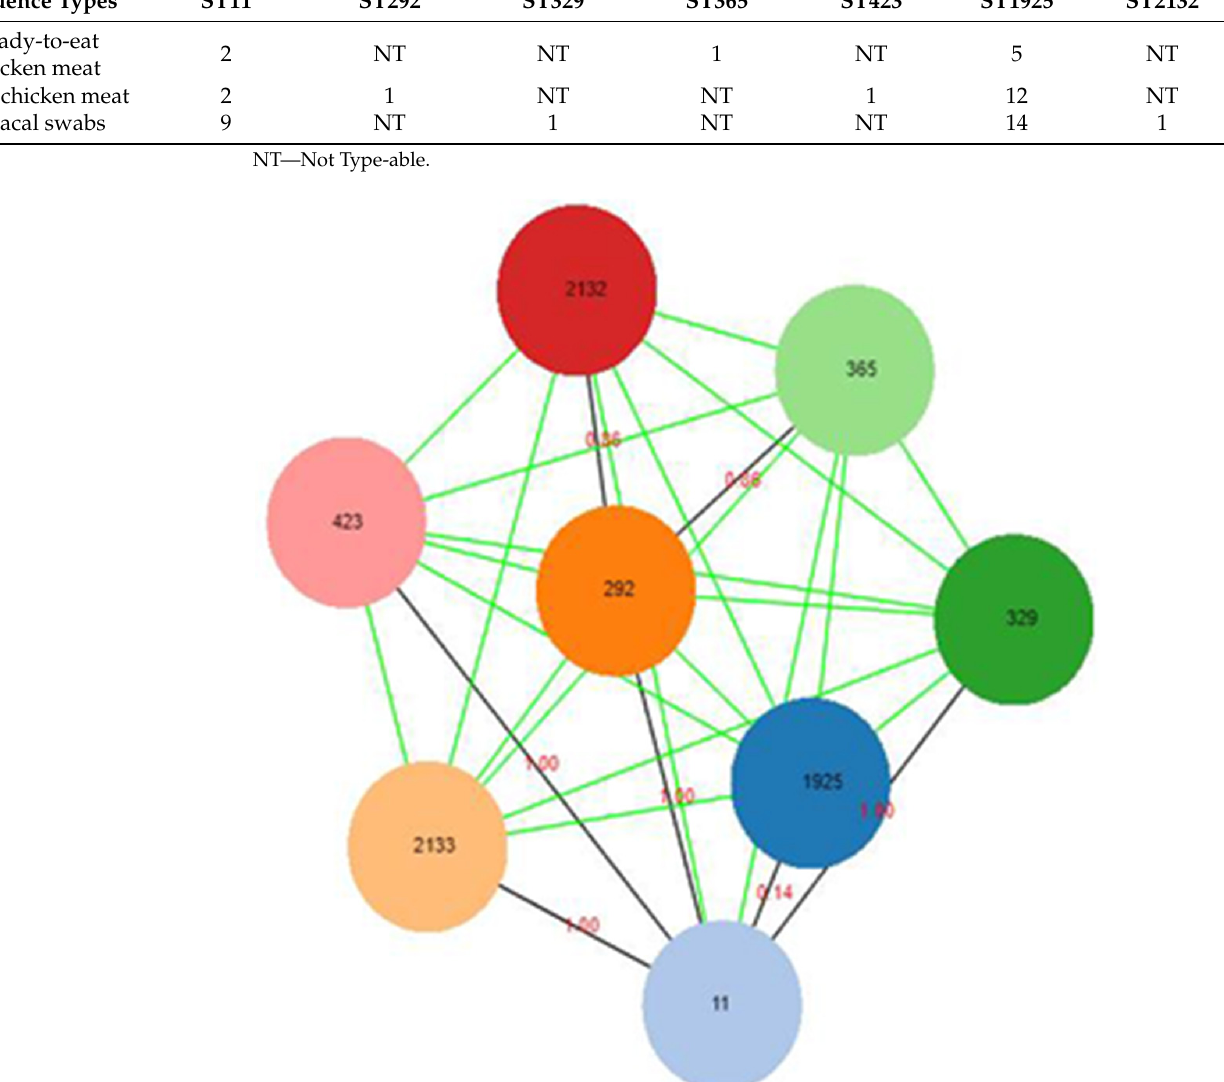
Table 4. MLST sequence types of Salmonella Enteritidis isolates.